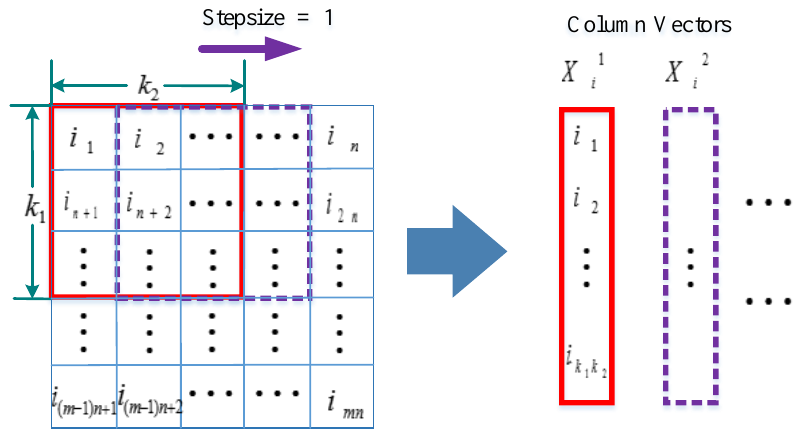
Figure 7. The principle diagram of the sliding window.